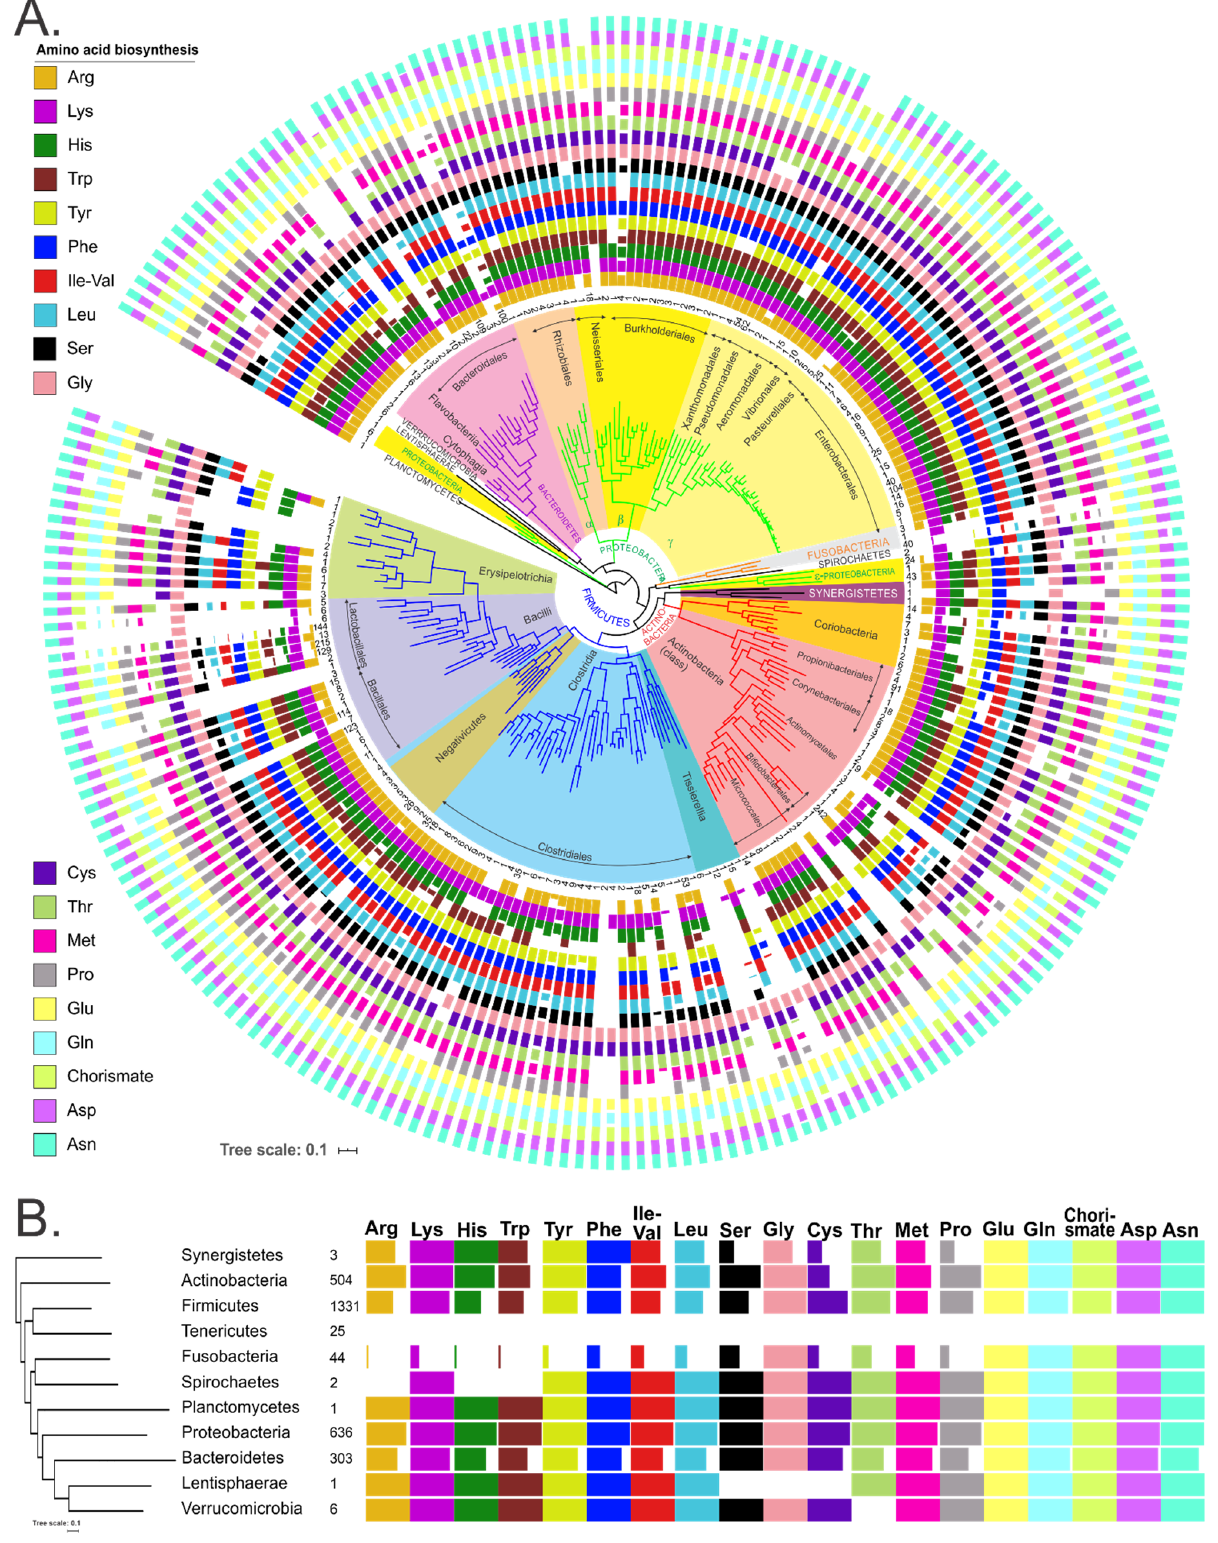
Figure 3. ( A ) Distribution of amino acids producers among analyzed HGM strains. Colored bars show the average amino acid prototrophy of each genus; empty bars represent auxotrophy. The phylogenetic tree of HGM genera was obtained using concatenated ribosomal proteins as previously described [25]. Number of analyzed strains per genus is shown in the inner circle. ( B ) Distribution of the amino acid producers at the phylum level. The number of analyzed genomes in each phylum is